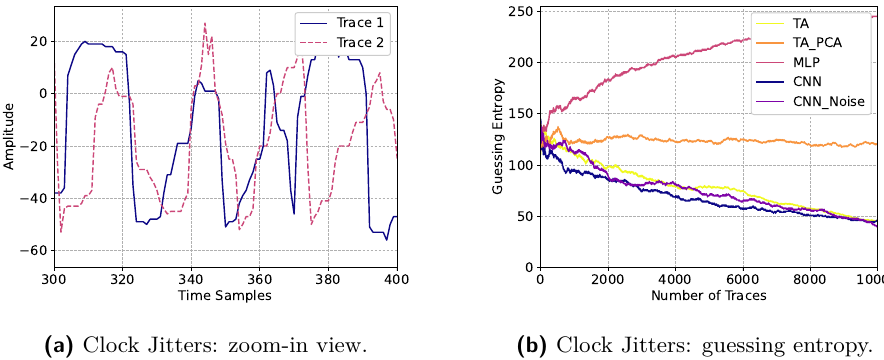
Figure 7: Clock Jitters: demonstration and its influence on guessing entropy.